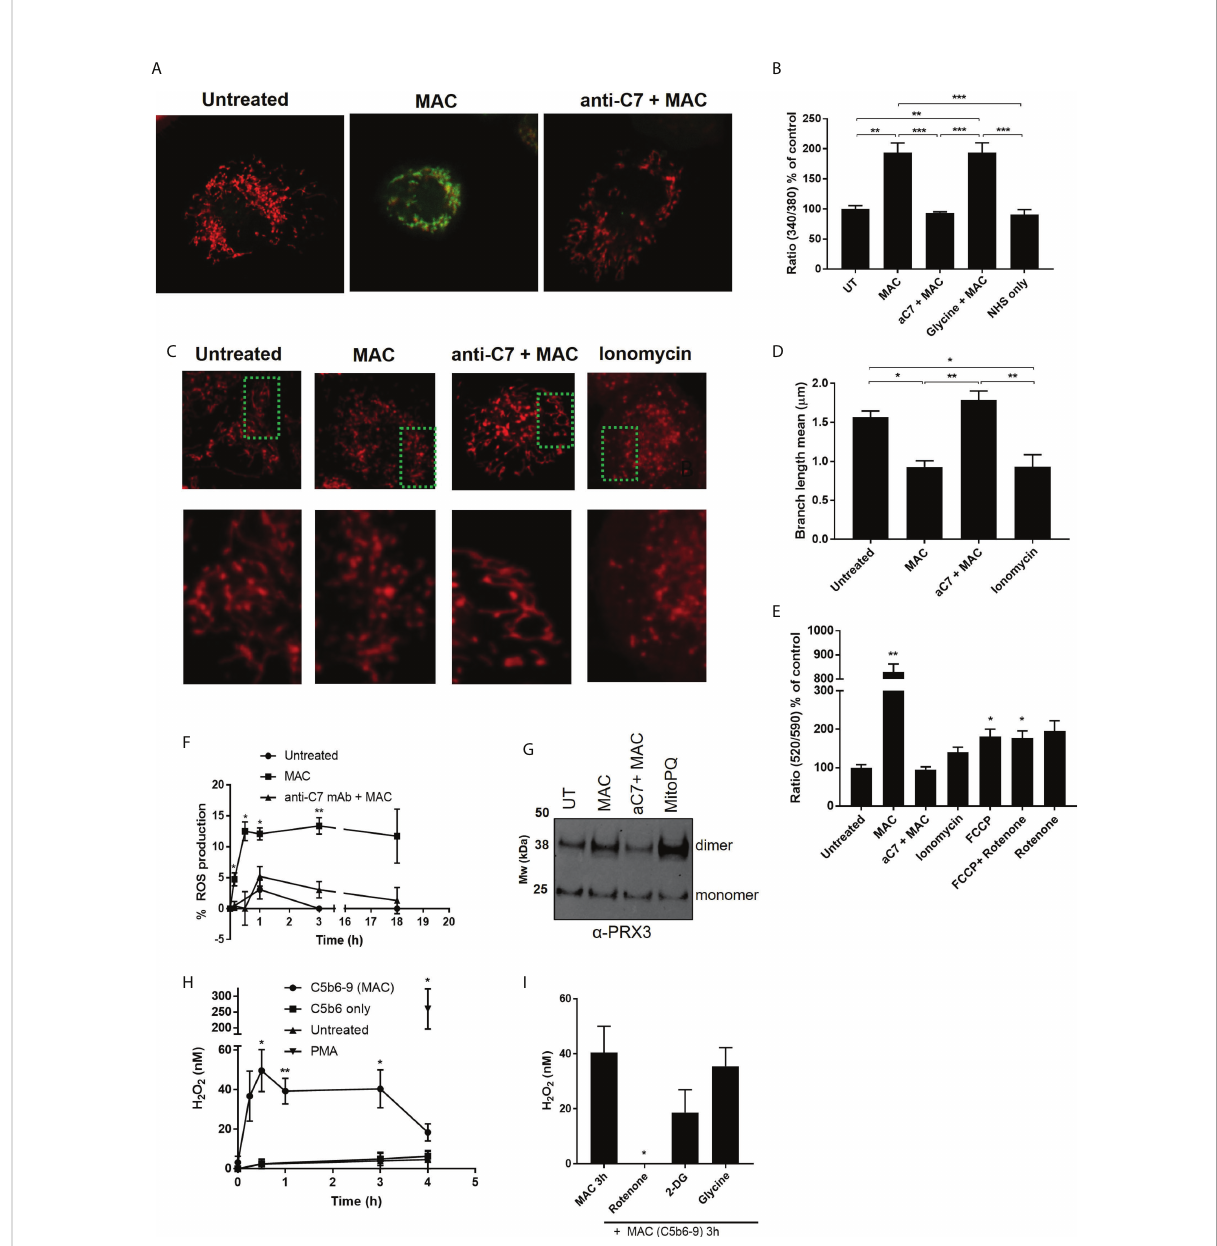
FIGURE 5 MAC drives disruption of mitochondrial dynamics and membrane potential, triggers increased intracellular calcium and mitochondrial ROS. (A, B) Intracellular calcium of hMDMs measured by Fura2 after MAC stimulation (± anti-C7 or glycine (5 mM)), NHS only or untreated for 1 h by fl uorescence plate reader (B; n=3) or select conditions by confocal microscopy (A; n=3, representative image shown). (C) hMDM were stained with 500 nM MitoTracker Red CMXRos for 15 min before MAC stimulation +/- anti-C7 or 5 m M ionomycin and imaged (n=4 independent donors; representative image shown). (D) Quanti fi cation of mitochondrial network morphology, expressed as mitochondrial branch length mean, from stimulations described in (C) were quanti fi ed from confocal microscopy images using MiNa Fiji/ImageJ software (n=4 cells per condition per donor analysed). (E) hMDMs were stimulated for 1 h with MAC (+/- anti-C7), 5 m M ionomycin, 1. 2 m M FCCP or 1 m M rotenone and membrane potential measured by JC-10 assay and normalised to untreated cells (n=3). (F) Intracellular ROS production measured over time by mean fl uorescence intensity using CellROX. hMDMs were stimulated with MAC (+/- anti-C7) and normalised to menadione (30 m M) treatment as positive control (n=3). (G) hMDMs were incubated with MAC (+/- anti-C7) or 5 m M MitoPQ for 3 hours and Prx3 dimerization measured by Western blot (n=3; representative blot shown). (H, I) H2O2 production of hMDMs stimulated with MAC (anti-CD59 plus C5b6-9 puri fi ed components (+/- 50 min pre-incubation with rotenone (0. 5 m M), 2-DG (5 mM) or Glycine (5 mM)) or with C5b6 only or 200 nM PMA only controls (n=4). Statistically signi fi cant data between MAC and control groups was assessed by (B, D) 1-way ANOVA with post-hoc Tukey ’ s test and (E, F, H, I) unpaired student ’ s t-test with Welch ’ s correction for unequal SDs. Signi fi cance comparisons in (E) are to UT, in (F, H) to respective time point of UT control and in (I) to MAC treatment. Error bars represent mean +/- S. E. M. * = p<0.05, ** = p<0.01, *** =